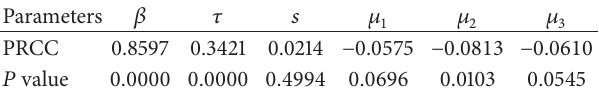
Table 1: PRCC results and 𝑃